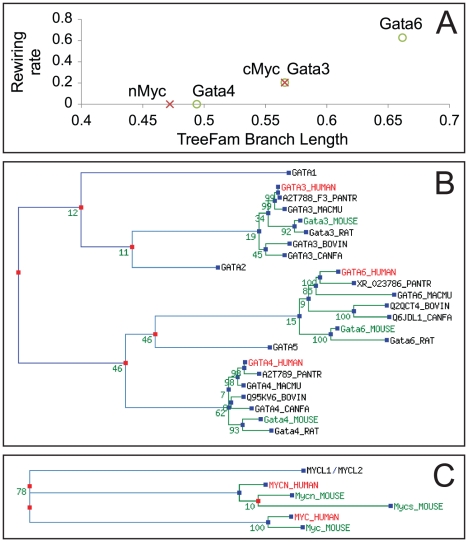
Re-wiring rate against divergence time.(A) Re-wiring rate against phylogenetic distance. Circles: Gata3/Gata4/Gata6 genes. Cross: cMyc(MYC)/nMyc(MYCN) genes. TreeFam branch length of a gene is the distance between the speciation event of the gene and the first duplication event in the paralogous family. (B, C) Phylogenetic trees of the Gata and the Myc families in mammals. Blue dot: gene speciation event. Red dot: gene duplication event. Branch lengths are estimated for the consensus tree of bootstrapped trees using HKY model. Numbers on branching events are the support numbers to the consensus tree in 100 bootstrapped trees.